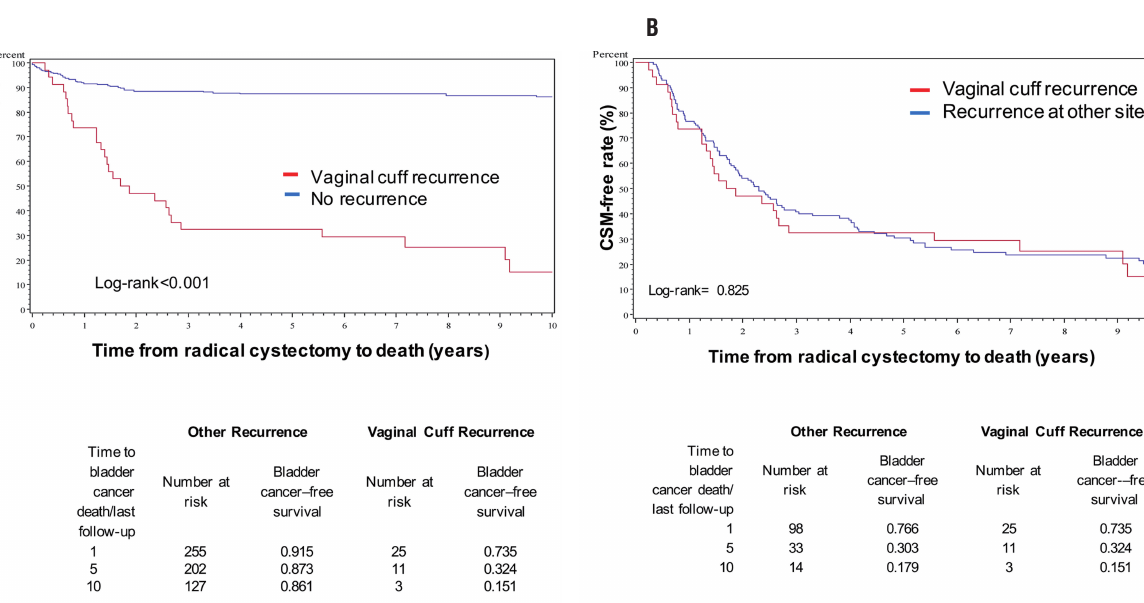
figure 3 - cancer Specific Mortality (cSM) for vaginal cuff Recurrence (3a) vs No Recurrence and vs Recurrence at Other